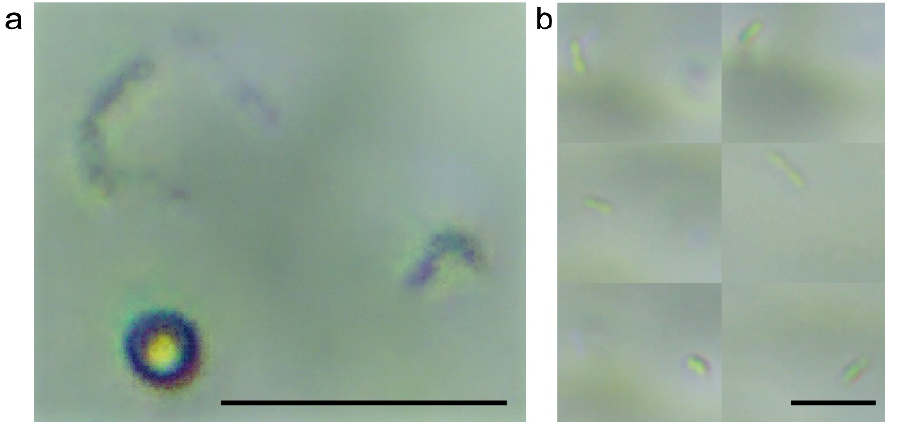
Figure 3. Comparison of stacking method (2D) and layer-by-layer scanning method (3D): ( a ) En- hanced depth of field mode (2D); ( b ) layer-by-layer scanning mode (3D). The scale bars represent 10 μ m.